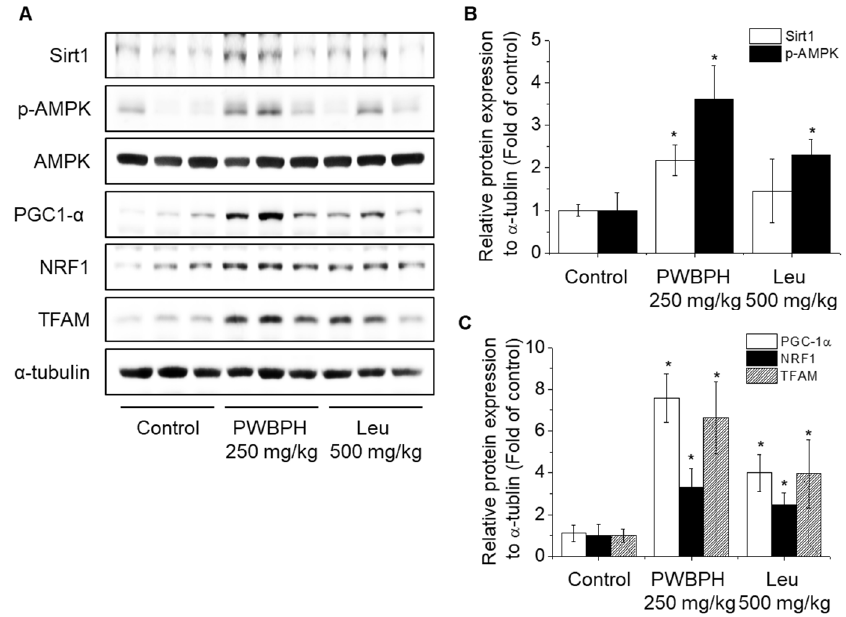
Figure 4. Effect of PWBPH on mitochondrial function-related protein levels in vivo. ( A ) The protein levels of SIRT1, p-AMPK, PGC-1 α , NRF1, and TFAM in QF muscle of the control, PWBPH 250 mg/kg, and Leu 500 mg/kg groups were determined by Western blotting and ( B , C ) the band intensities were measured using ImageJ software. * p < 0.05 vs. control group.